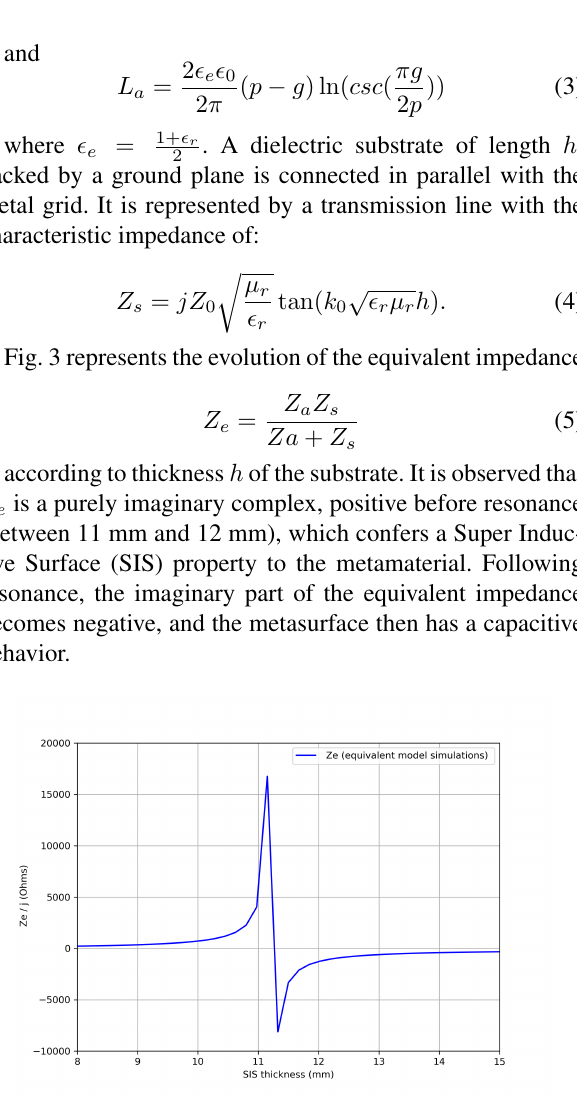
FIGURE 3. Imaginary part of the SIS equivalent